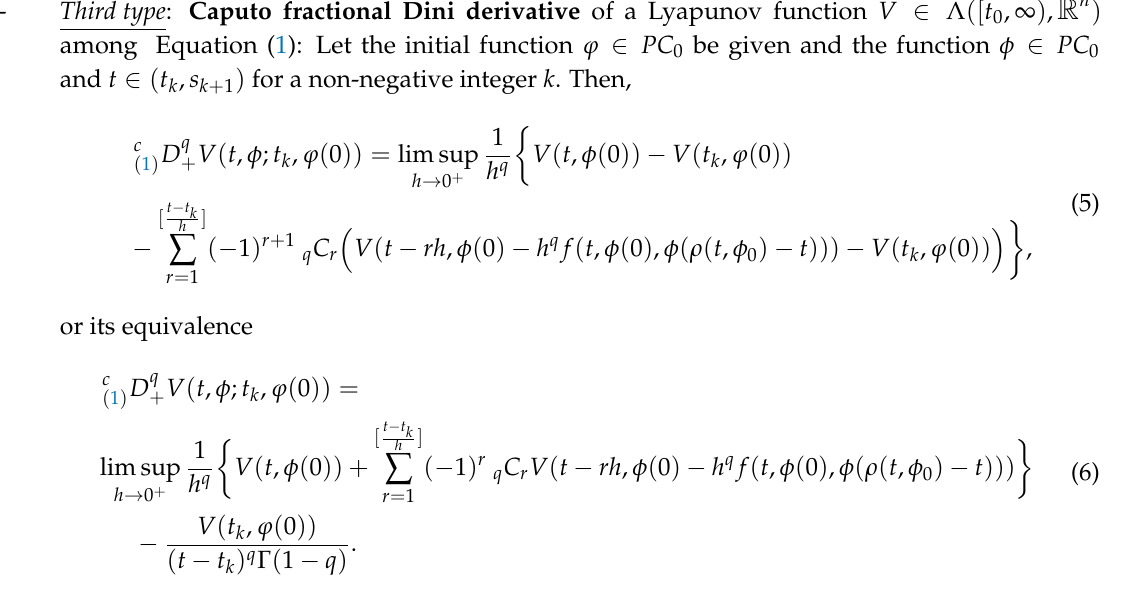
Third type : Caputo fractional Dini derivative of a Lyapunov function V ∈ Λ ([ t 0 , ∞ ) ,